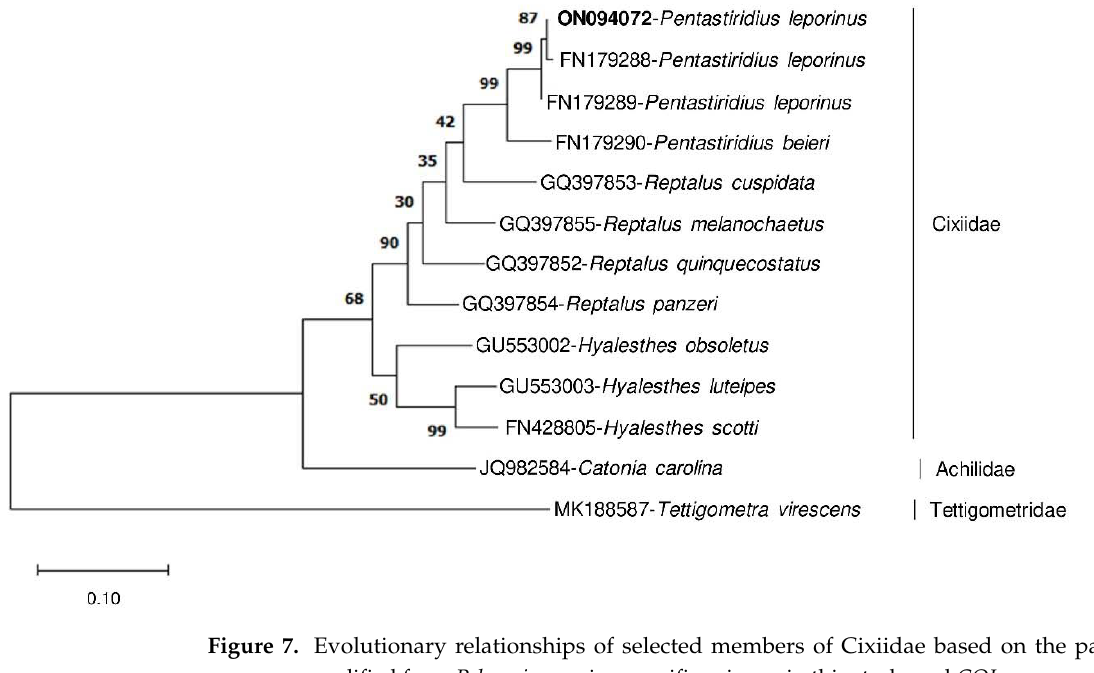
Figure 7. Evolutionary relationships of selected members of Cixiidae based on the partial COI sequence amplified from P. leporinus using specific primers in this study and COI sequences from the NCBI database of closely related species from genus Pentastiridius and each three species from two taxonomically close genera Reptalus and Hyalesthes. The sequence obtained in this study is shown in bold. The percentage of replicate trees in which the associated taxa clustered together in the bootstrap test (1000 replicates) are shown next to the branches. The specifically amplified COI fragment is differentiating the closely related species. Catonia carolina from the Achilidae family and Tettigometra virescens from the Tettigometridae family were used as outgroups.